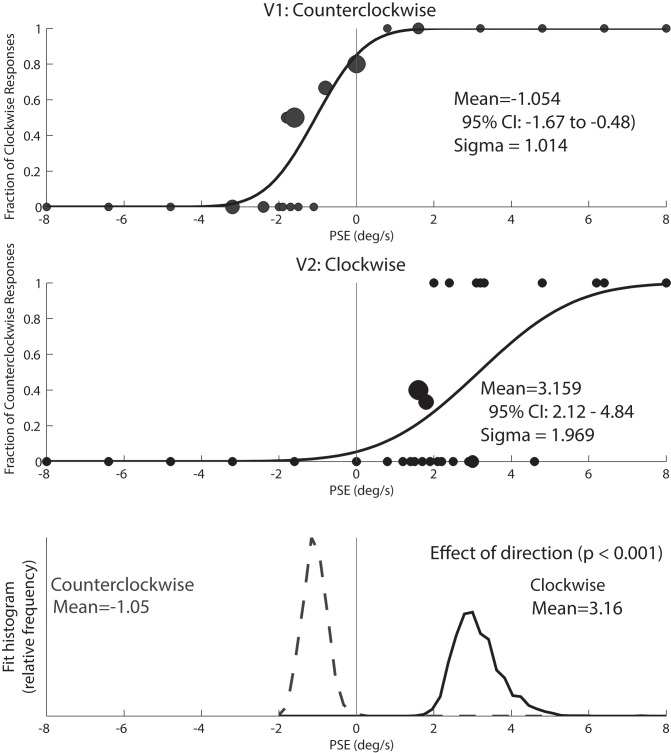
Individual psychometric fitting for an 8s PSE stimulus in an individual subject.Circles in the two upper panels are sized proportionally to the number of responses represented. A cumulative distribution function (CDF) was calculated from each data set as a method for determining the mean (bias) and sigma (threshold) of inertial motion detection for each test condition. Each panel combines data from 2 staircases that started at opposite extremes (-8 and +8 deg/s). Both staircases could cross zero depending on the subject’s responses. In this subject, the CDF had a significant shift towards the right when clockwise motion was presented (top panel) when compared with counterclockwise visual motion (middle panel). Each CDF was fit to the data 2,000x after being randomly resampled prior to each fit. The histograms of these fits are shown in the bottom panel which demonstrates a significant difference between the two conditions based on no overlap between the curves. The area under each curve is the same, and the y axis is arbitrary. The counterclockwise stimulus is represented by dashed line, clockwise stimulus is represented by the solid line.